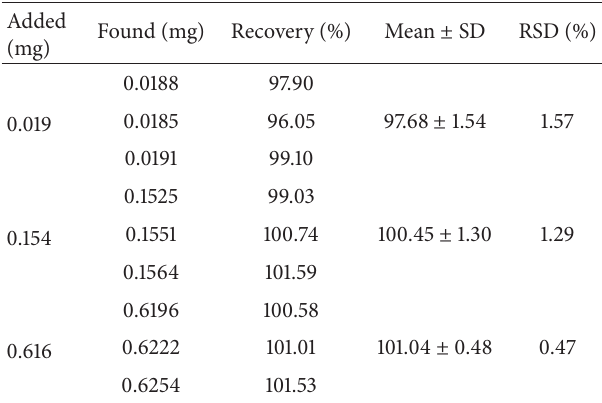
Table 1: Recovery test ( 𝑛 = 3